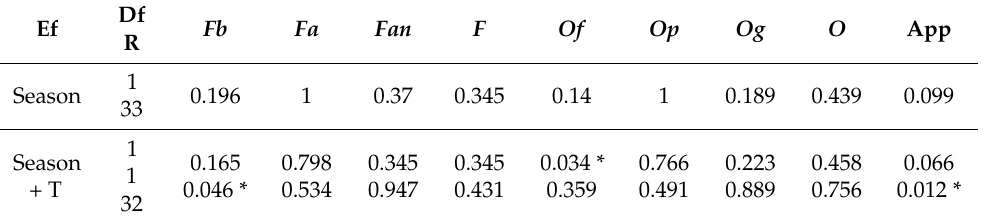
Table 3. The results of the 1- and 2-way PERMANOVA tests are reported as pseudo-F